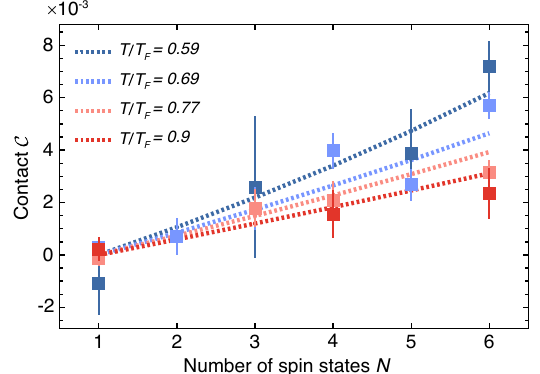
FIG. 9. Contact as a function of spin component N at different temperatures T=T F . Experimental results are denoted by boxes. Dotted lines represent theoretical results including corrections up to fourth-order virial expansion. All theoretical curves include a factor of